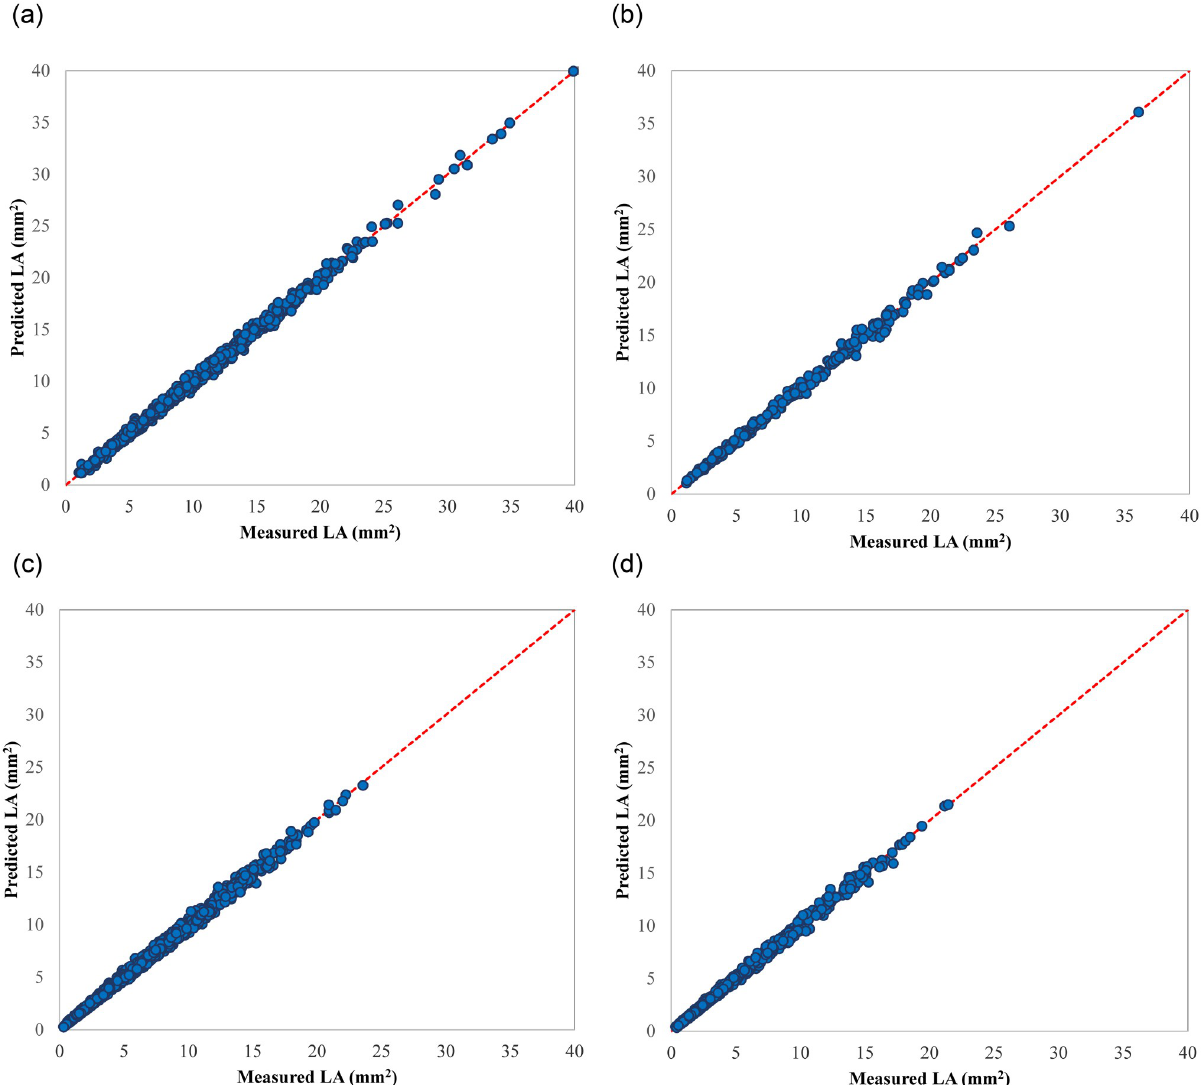
Fig 9. Scatter plots of the estimated LA values of selected ANN models v. the corresponding measured values; a) the 2019 data-driven ANN on the training dataset, b) the 2019 data-driven ANN on the test dataset, c) the 2021 data-driven ANN on the training dataset, and d) the 2021 data- driven ANN on the test dataset.